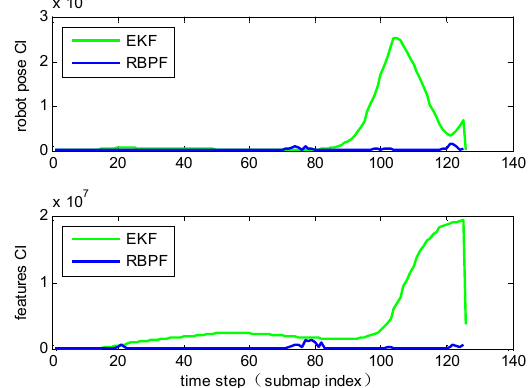
Figure 6. Mean consistency index CI of robot pose and features for the four